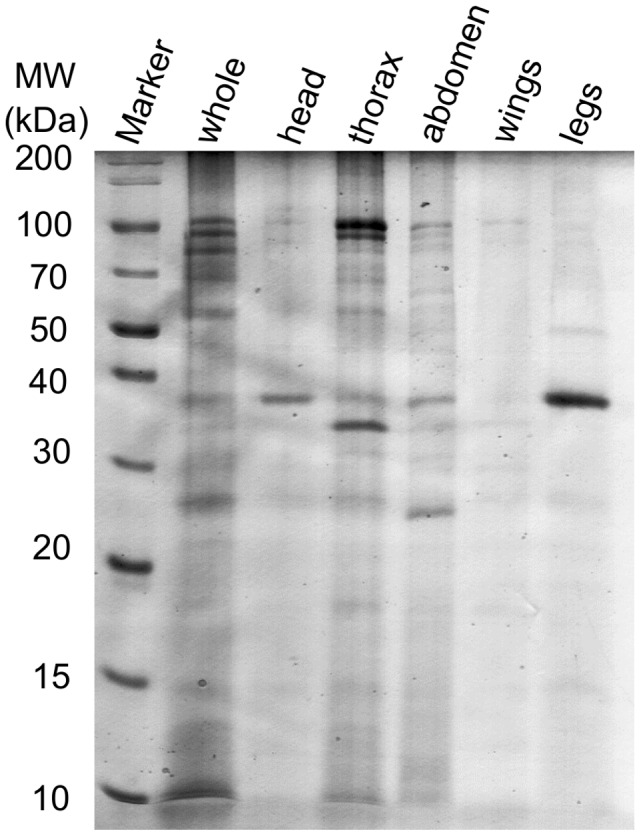
SDS PAGE separation of Glossina palpalis gambiensis protein extracts.SDS-PAGE separation of the whole insect and bodyparts of Glossina palpalis gambiensis extracts. 10 µg of proteins were run on 12% SDS-PAGE and stained with Coomassie brilliant blue.